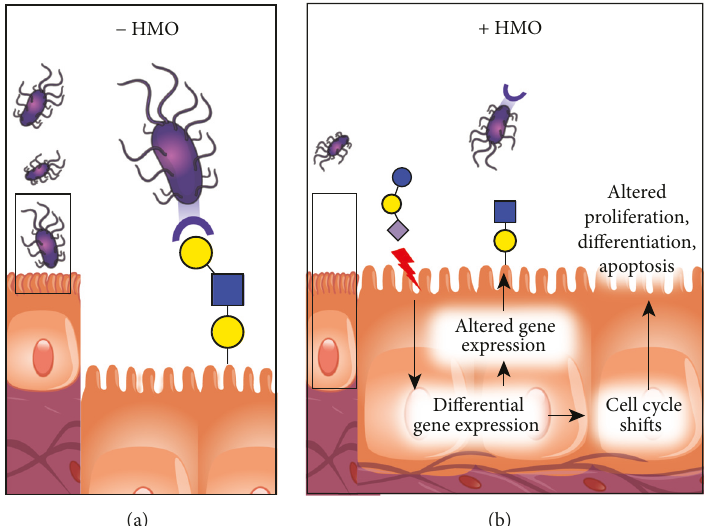
Figure 5: Gut epithelial cells in (a) absenceof HMOs and (b) presenceof HMOs. The interactionwith HMOs leads to altered gene expression and growth of the intestinal epithelial